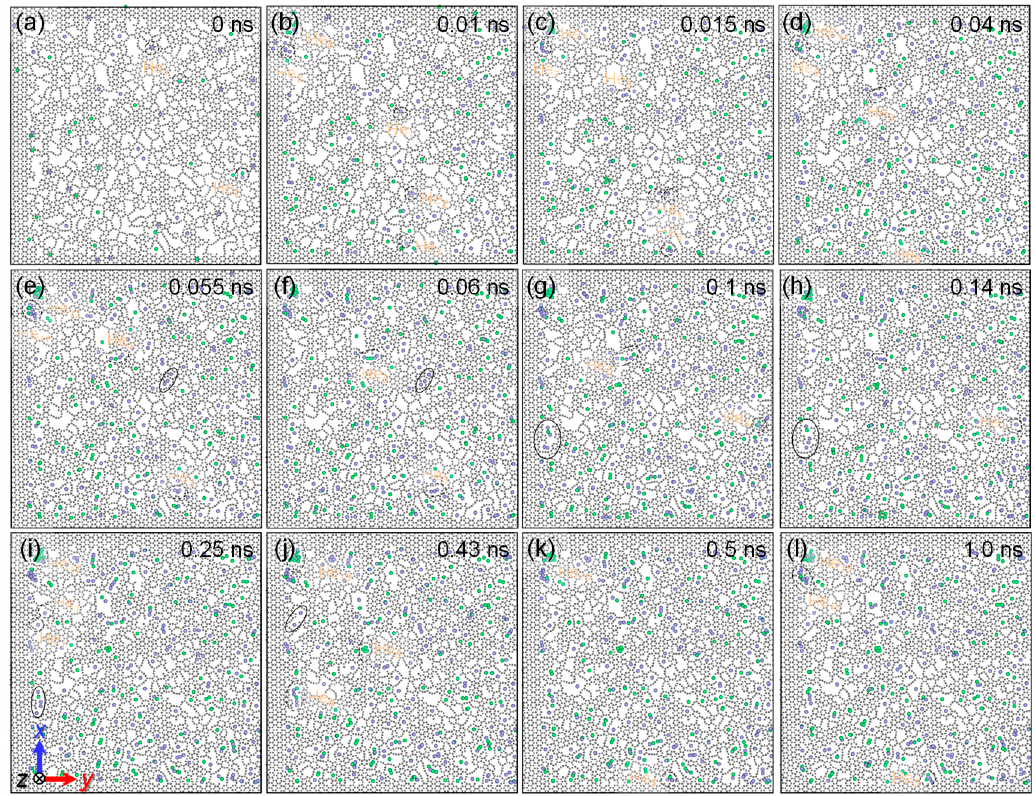
Figure 9. Snapshots of He diffusion along the defective NGI at times of 0 ns ( a ), 0.01 ( b ), 0.015 ( c ), 0.04 ( d ), 0.055 ( e ), 0.06 ( f ), 0.1 ( g ), 0.14 ( h ), 0.25 ( i ), 0.43 ( j ), 0.5 ( k ), and 1.0 ns ( l ).